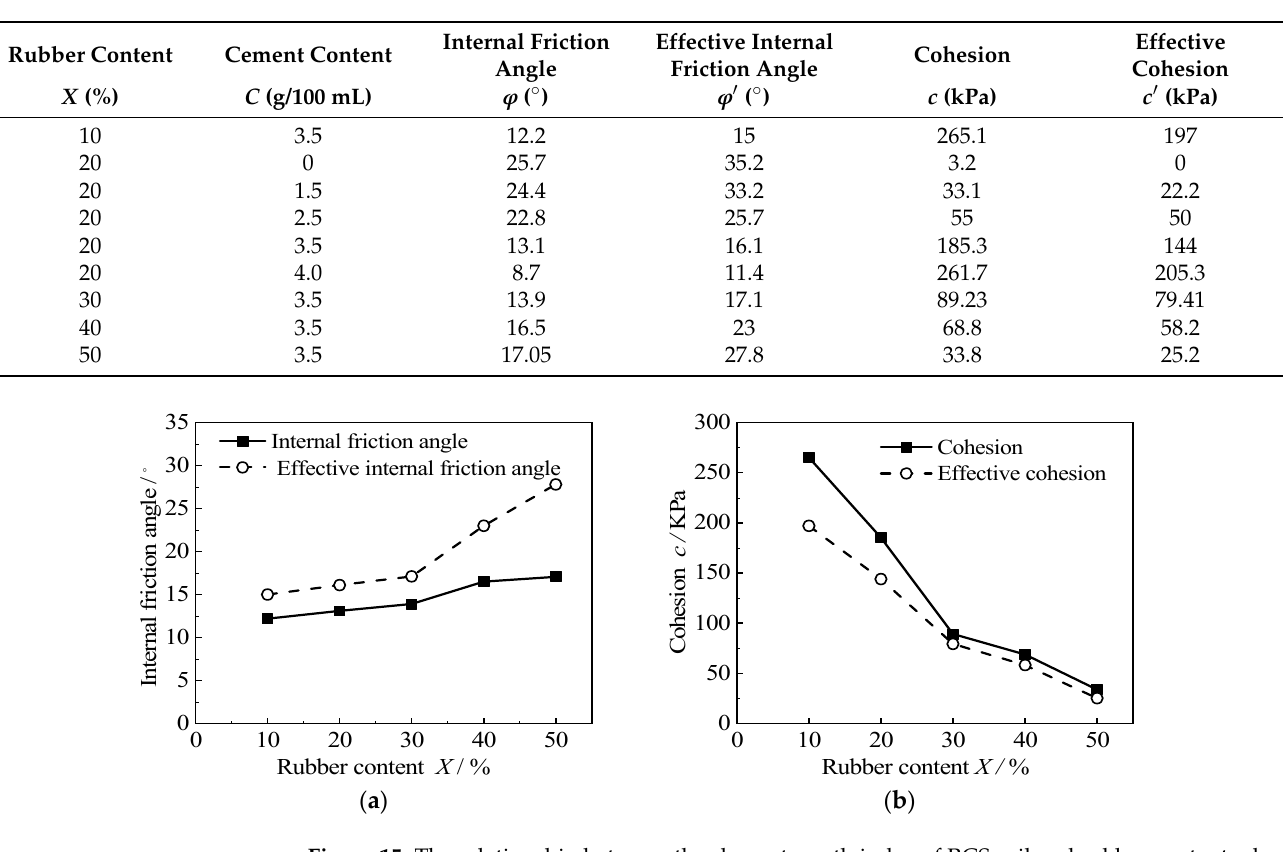
Table 4. Shear strength index of RCS soil.